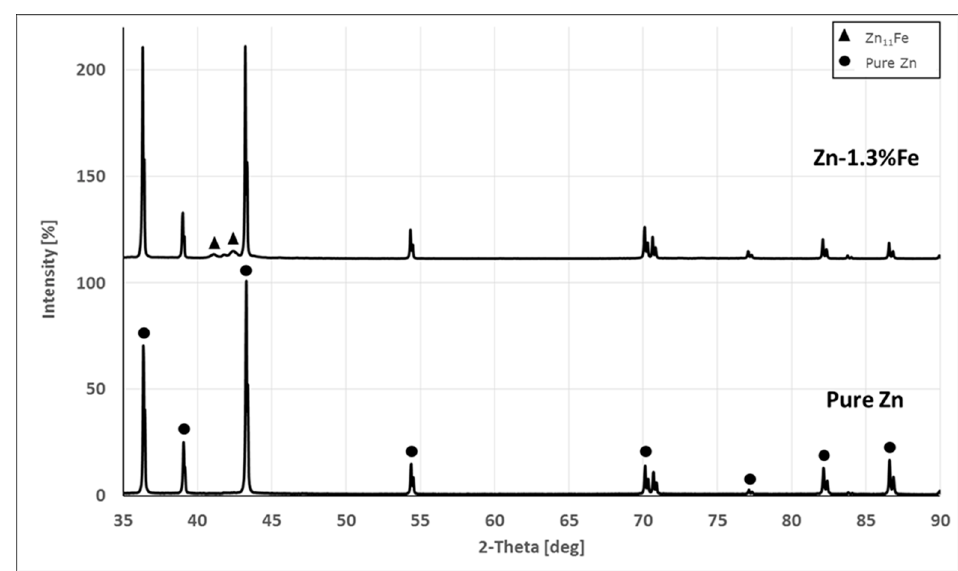
Figure 2. X-ray diffraction analysis of pure Zn and Zn–1.3Fe alloy.